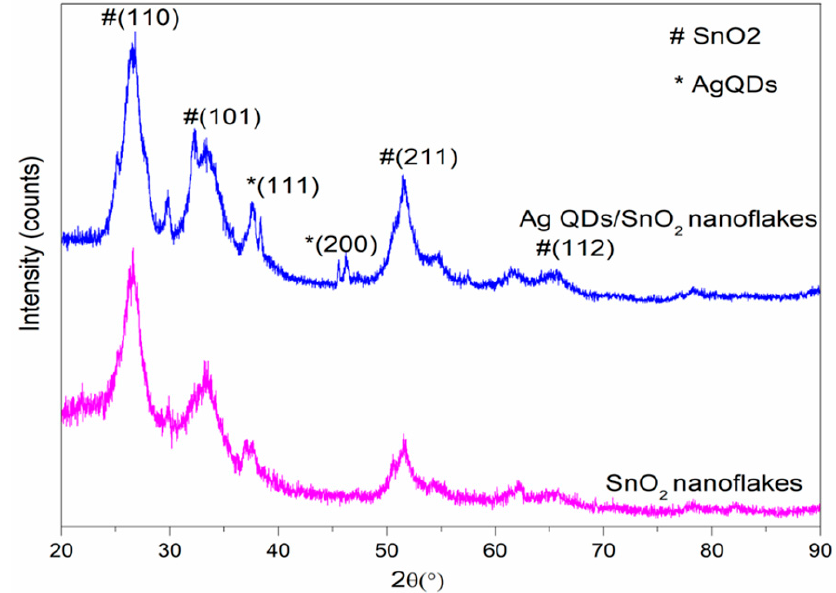
Figure 1. Powder x-ray diffraction ( PXRD) spectra of the SnO 2 and Ag QD/SnO 2 nanostructures.